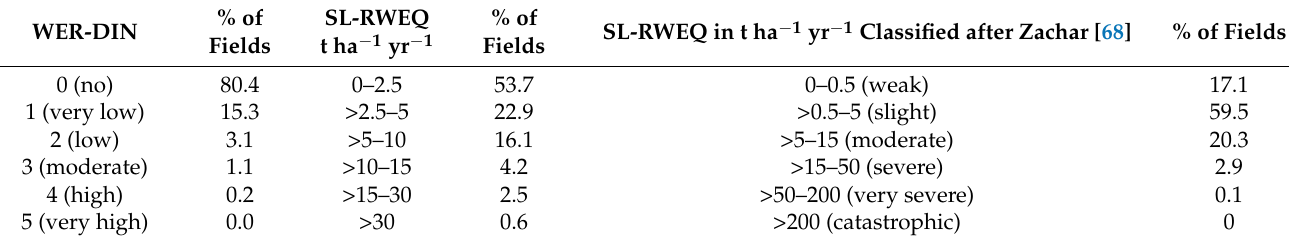
Table 2. Distribution of the proportion of wind erosion risk according to DIN 19706 (WER-DIN) and soil loss classes according to revised wind erosion equation (SL-RWEQ) on a field